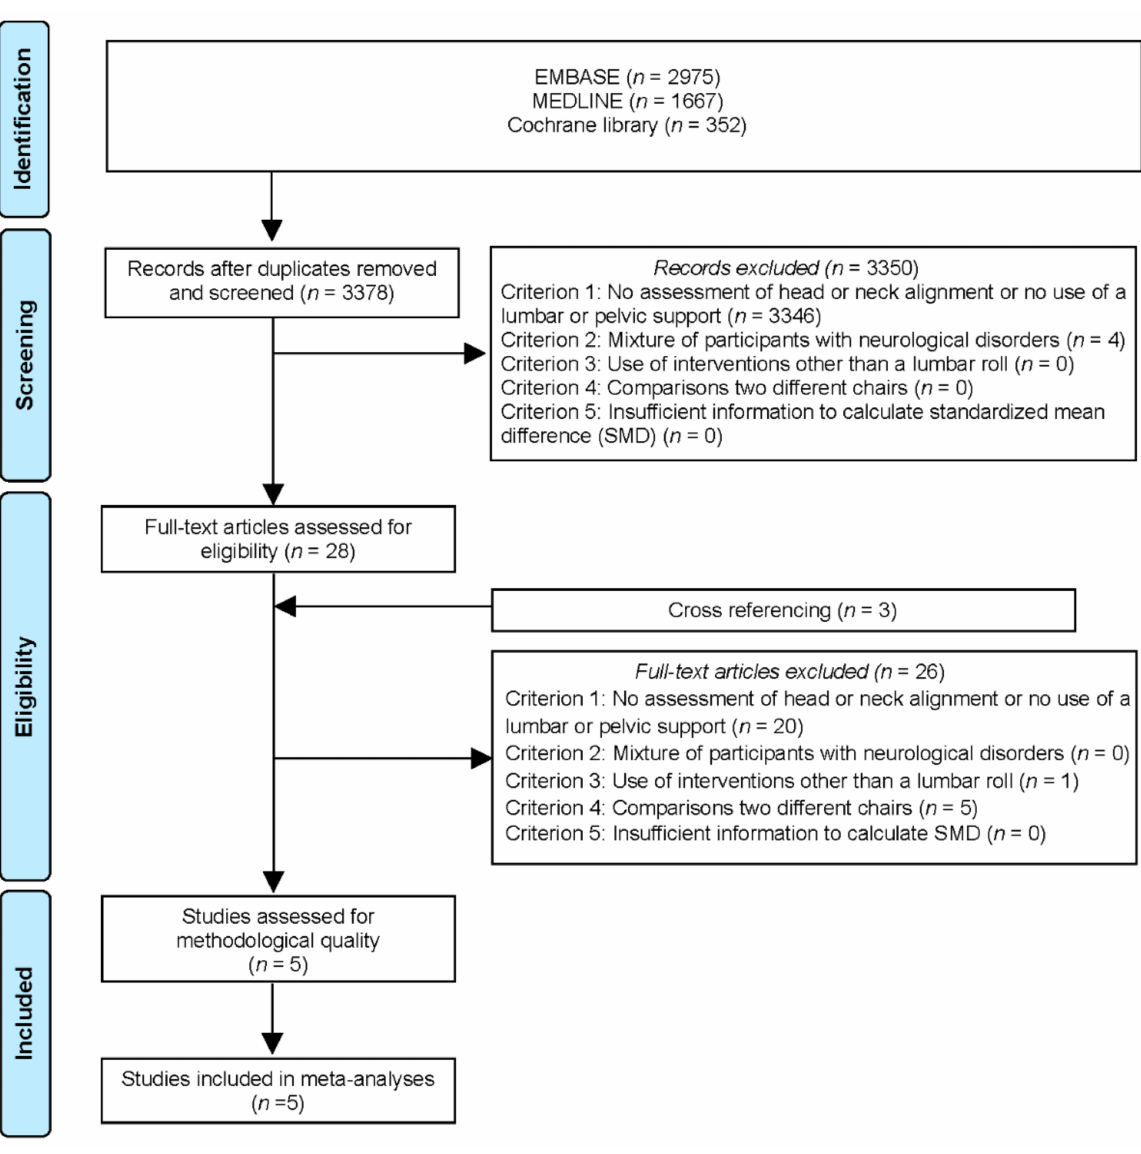
Figure 1. Flow of study